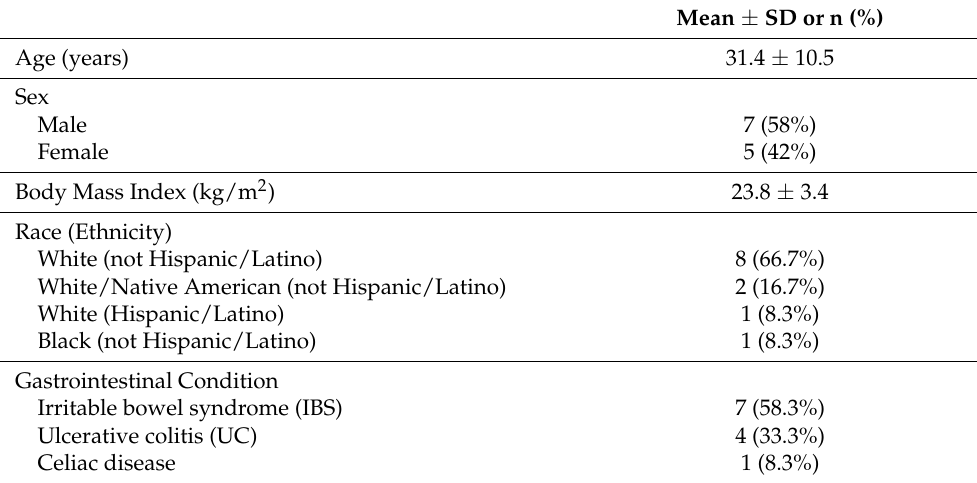
Table 3. Pilot Trial Participant Demographics.